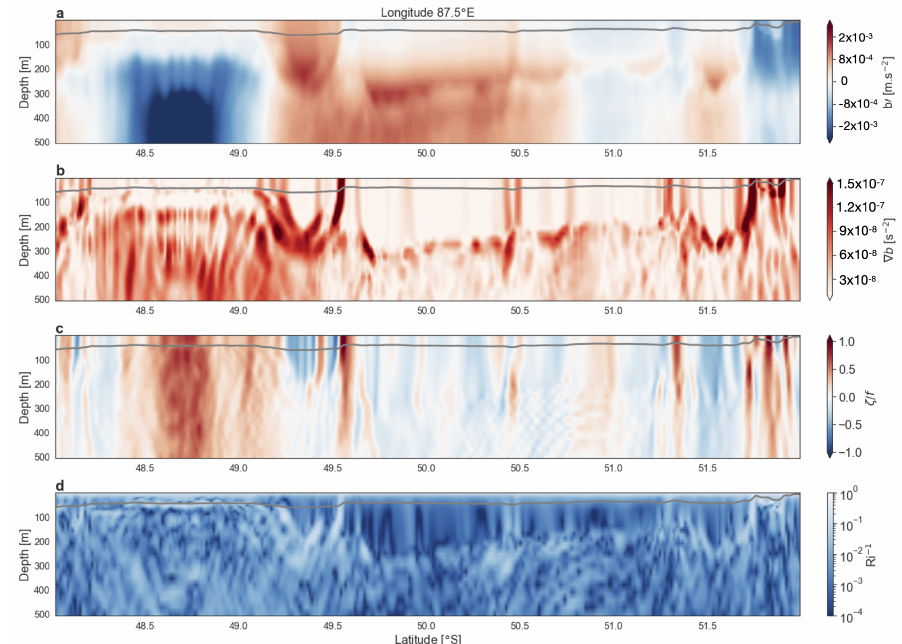
Figure 2. Vertical/meridional section taken at a longitude of 87.5 ◦ E (dashed gray line in Figure 1) of ( a ) buoyancy anomaly b (cid:48) . ( b ) Buoyancy gradient |∇ b | . ( c ) Rossby number ζ / f . ( d ) Inverse Richardson number Ri − 1 . The MLD is shown in gray and corresponds to a density increase of 0.03 kg m − 3 from the density at 10 m. Randomly selected snapshot on 27 October 2011 00:00:00